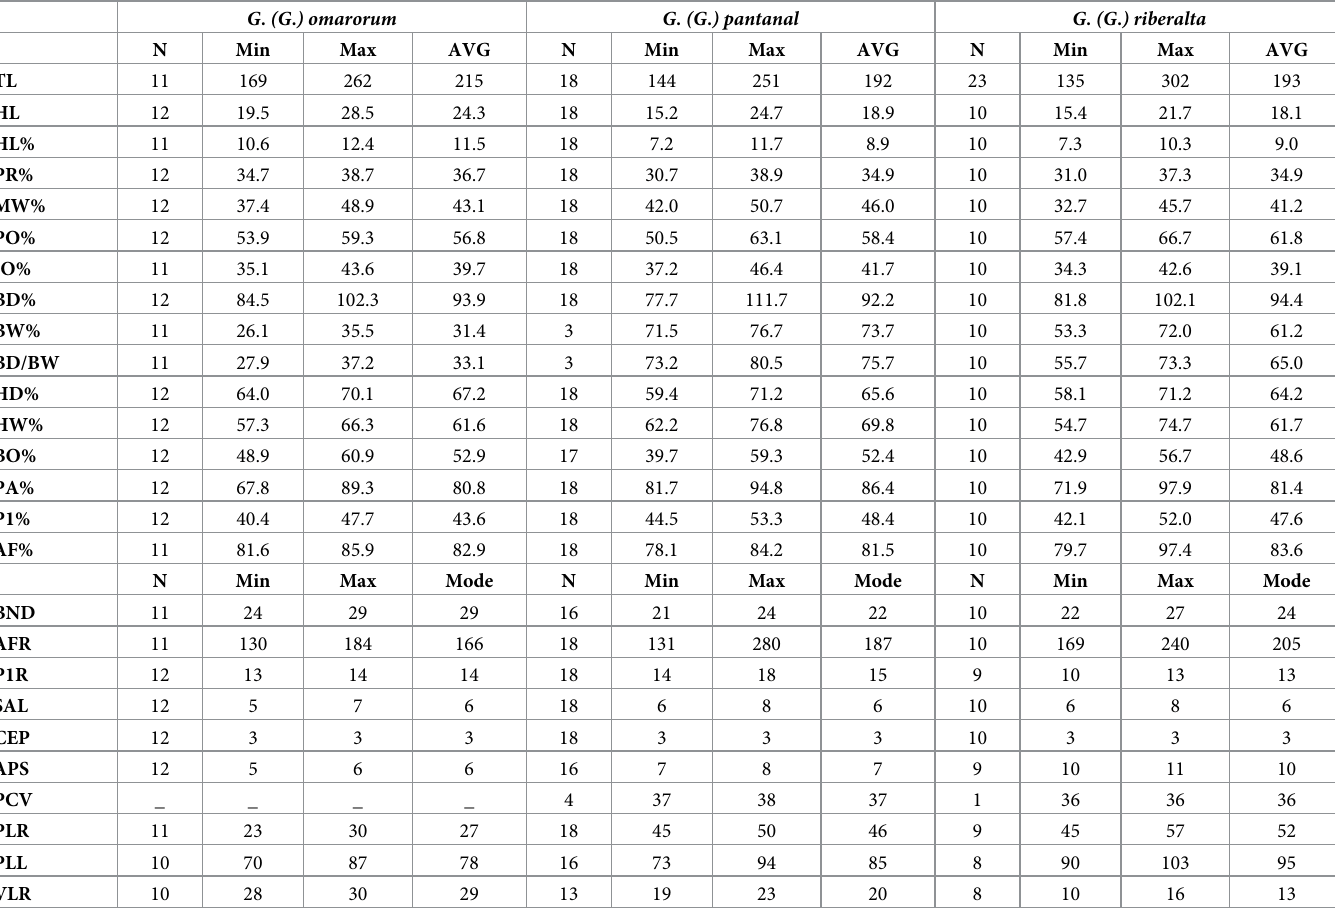
Table 11. Summary of morphometric and meristic data for Gymnotus (G . ) omrorum , G . (G . ) pantanal and G . (G . ) riberalta . G . (G . )